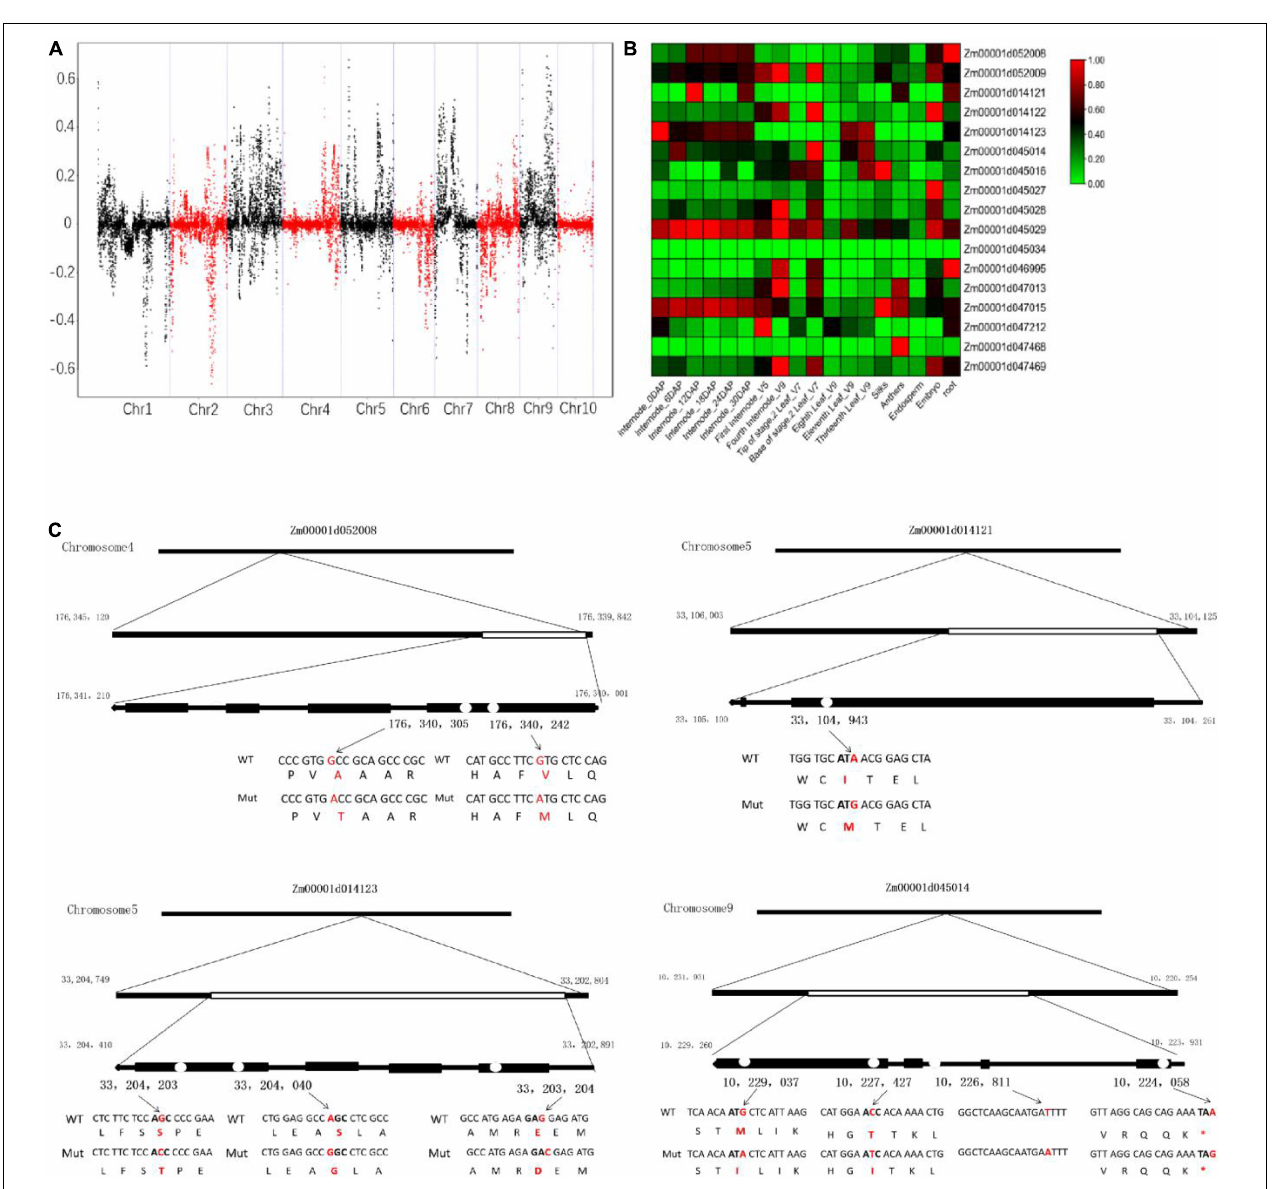
FIGURE 8 | Allele frequency difference graph from bulked-segregant sequence analysis (A) , heat map of expression profiles of candidate genes in maize (B) , and the sequence variations of the candidate genes related to the cellulose and lignin synthesis (C) . The standard deviations for the genome-wide median were chosen based on the threshold value of the confidence interval of